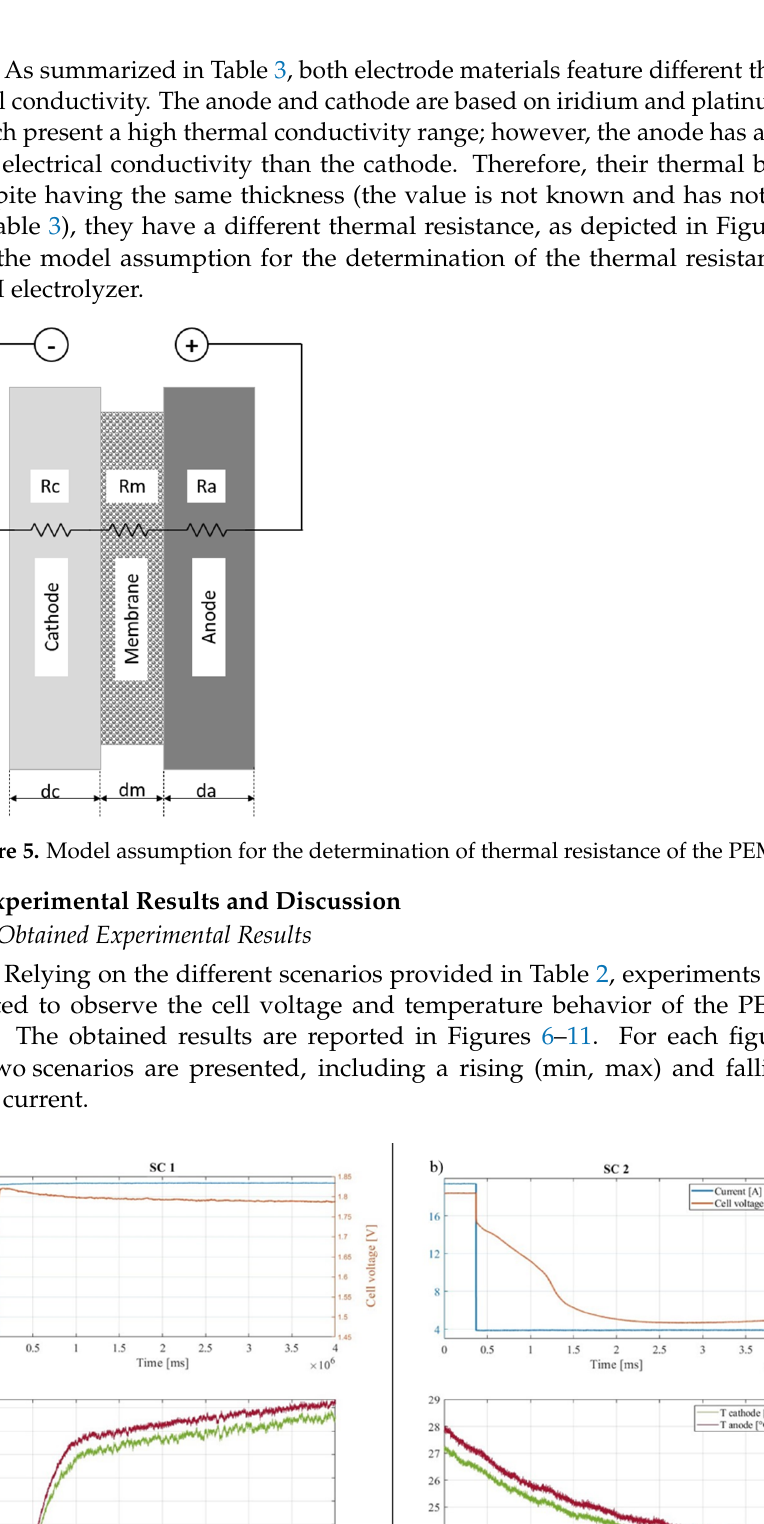
Table 3. Synthesis of materials, geometry, and electrical and thermal properties of the PEM electro- lyzer cell.